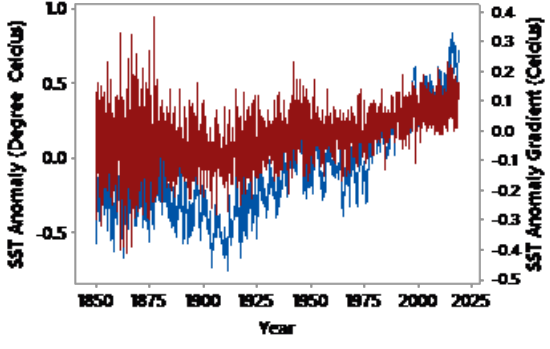
Fig. 2. GMSST (blue) and their AR(1) free gradients, ∆ GMSST.